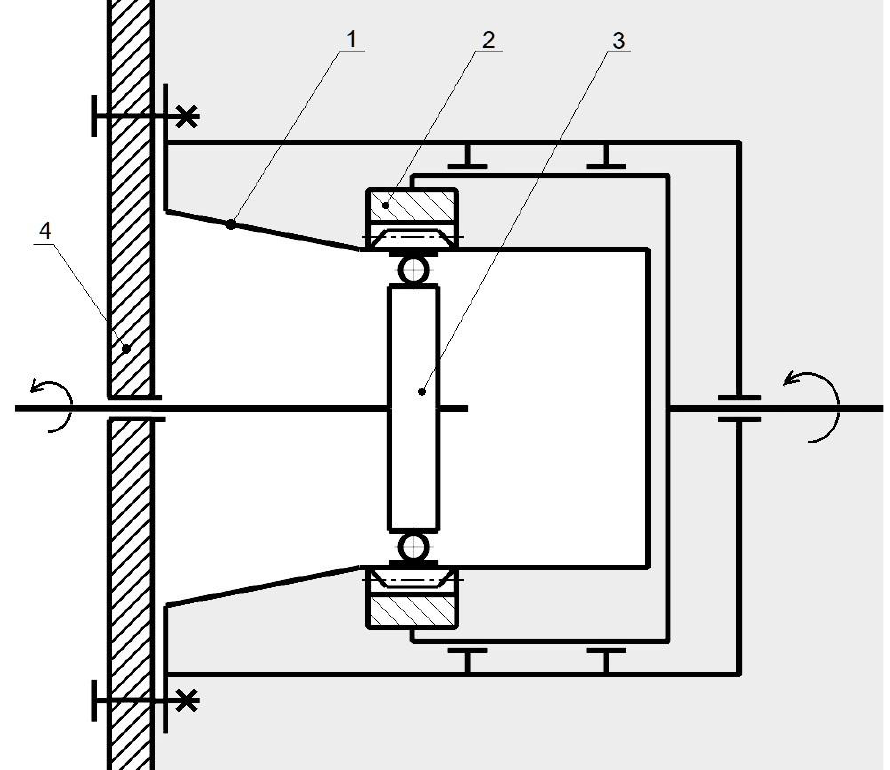
Figure 1. Schematic of the hermetic harmonic drive: 1 — circular spline, 2 — flexspline, 3 — wave generator, 4 — hermetic partition.